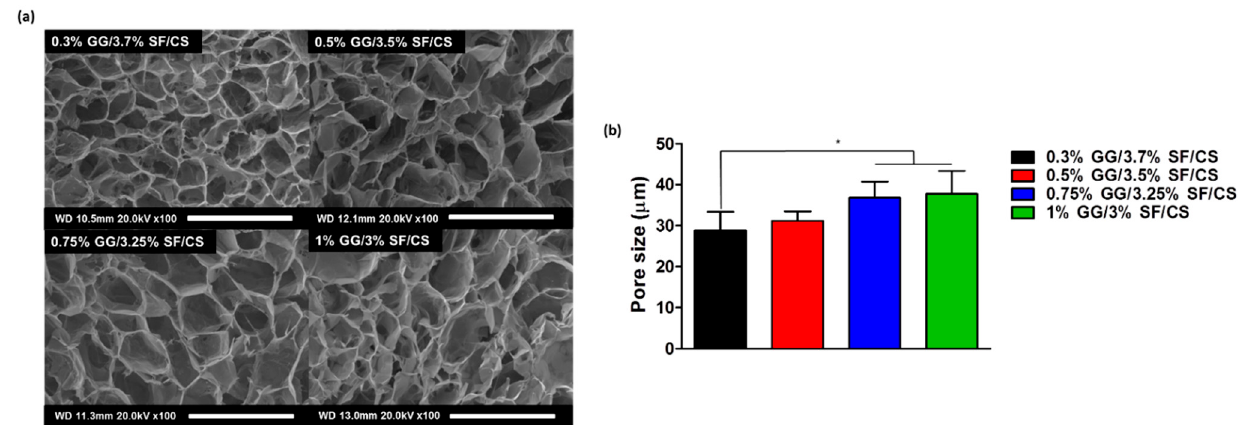
Figure 2. Morphological observation of the hydrogels: ( a ) SEM observation of hydrogel morphology and ( b ) pore size of hydrogel (scale bar = 100 μ m) (values are mean ± SD, n = 3, p < 0.05 (*)).